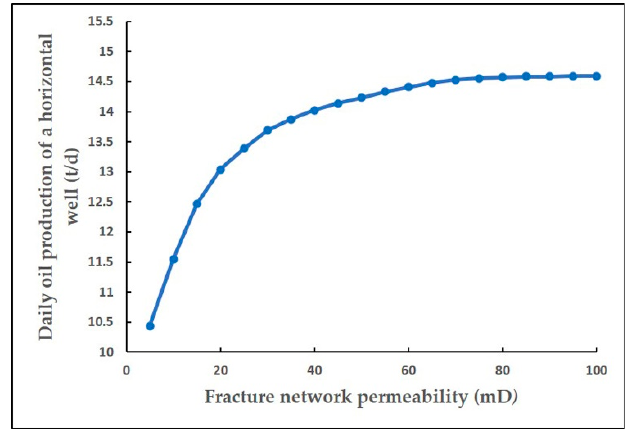
Figure 9. The influence of fracture network permeability on horizontal well production.